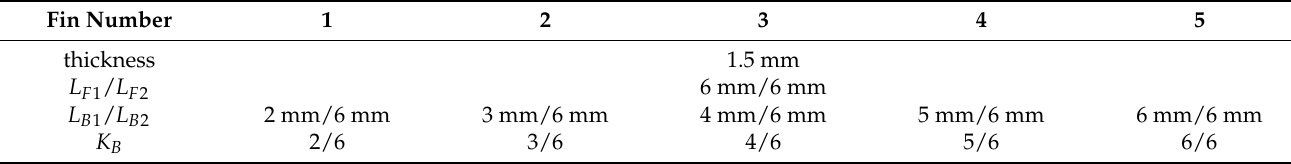
Table 1. Details of rear-edge flexibility design.